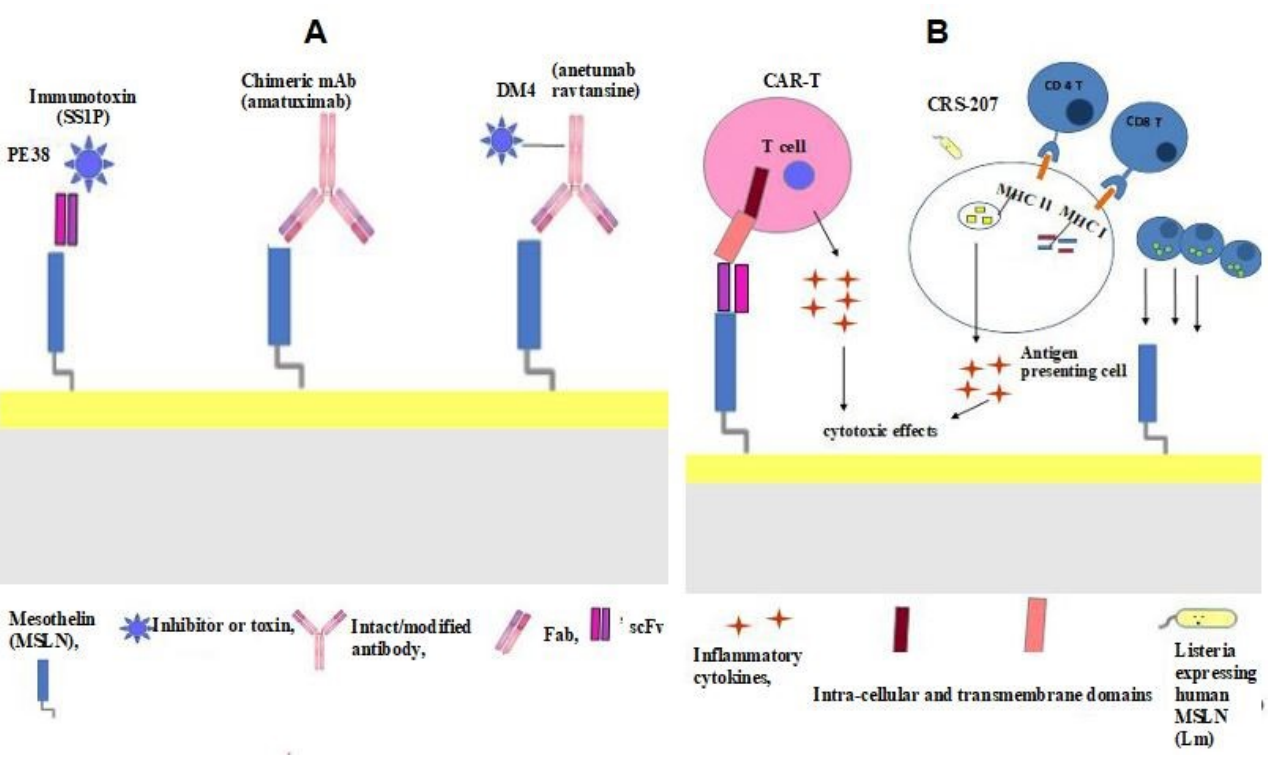
Figure 3. Schematic and simplified representation of the main therapeutic strategies that use mesothelin as a target. ( A ) PE translocated in cytosol and killed cells, catalysing protein synthesis and initiating programmed cell death. DM4 binding to tubulin disrupts the microtubule polymerisation, causing cell cycle arrest, apoptosis, and the killing of the dividing cells. ( B ) Attached to MSLN, CAR T cells become activated and stimulate the host immune system with the production of inflammatory cytokines. In CR-207, Listeria monocytogenes (Lm) and its antigens into the cytosol can be loaded onto major histocompatibility complex (MHC) I and MCH II, causing the activation of potent CD4 helper lymphocytes and CD8 cytotoxic lymphocytes, or activating pro-inflammatory genes, which can amplify the cytotoxic effect caused by inflammatory cytokines.